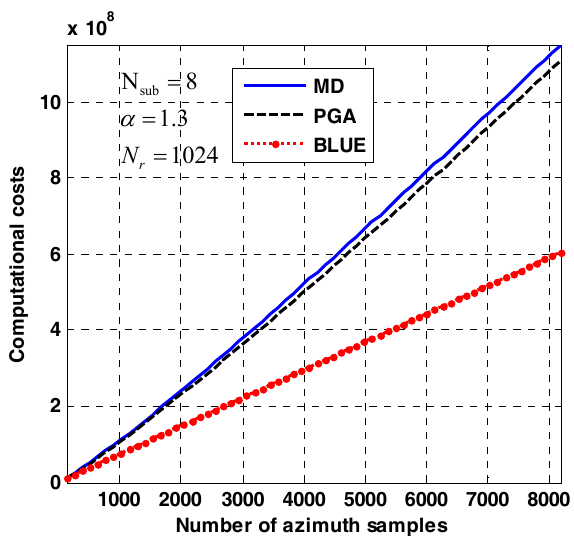
Figure 23. Computational cost comparison of different algorithms. The blue line, dark dashed one, and red dot-dashed one are the computational costs of MD, PGA, and BLUE algorithms, respectively.